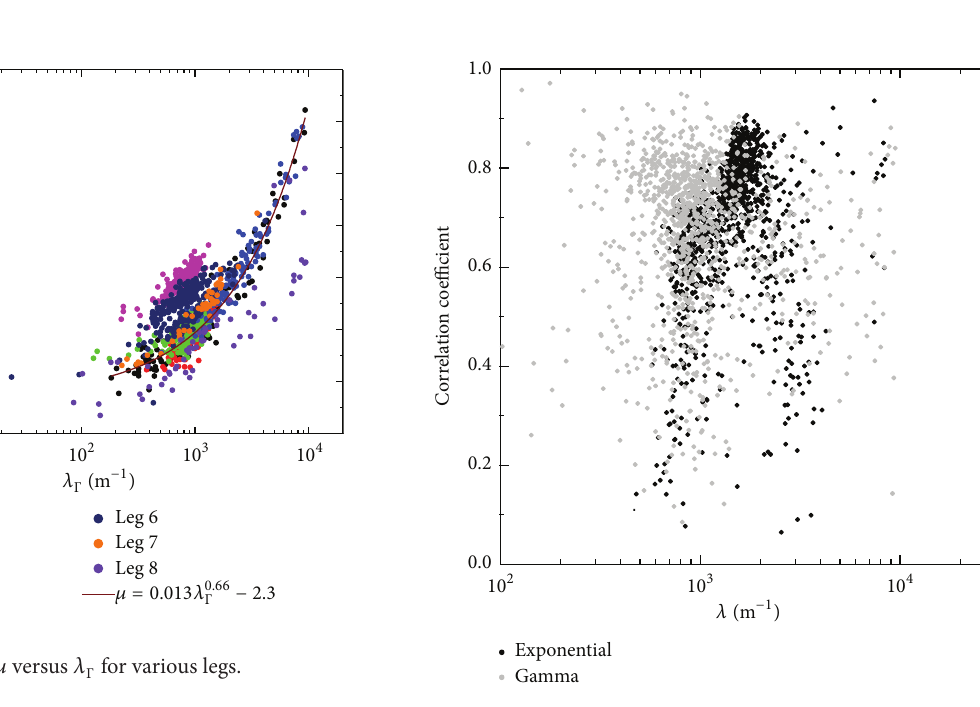
Figure 10: (a) 𝑁 0 versus 𝜆 and (b) 𝑁 0Γ versus 𝜆 Γ for various legs.